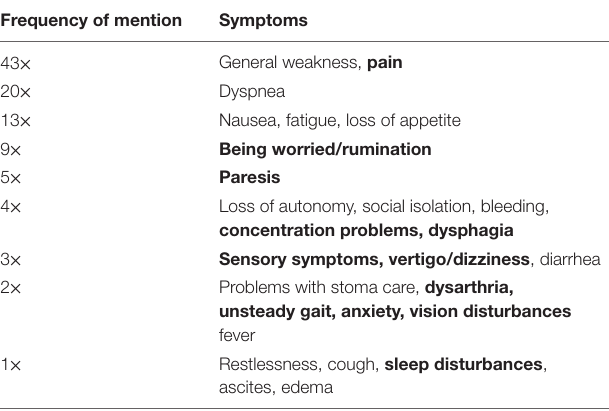
Neurological and neuropsychiatric symptoms as assessed in the questionnaire study are printed in bold.